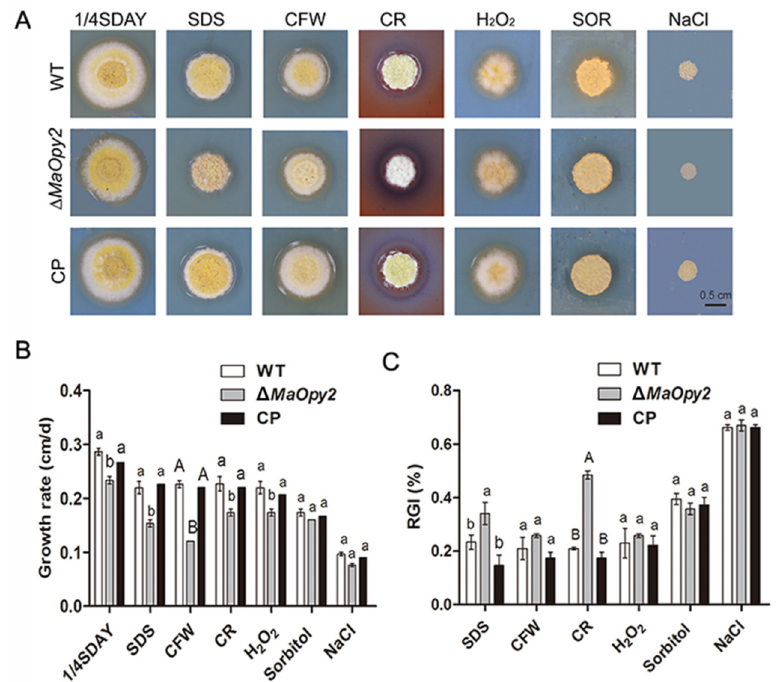
Figure 3. Tolerance to chemicals. ( A ) Colonies of different strains on the 1/4 SDAY medium or 1/4 SDAY medium supplied with different chemical compounds for 5 days. ( B ) Fungal growth rate on the different medium for the 5-day cultivation. ( C ) Relative growth inhibition by different chemicals. A & B and a & b presented the significant difference at p < 0.01 and p < 0.05, respectively.